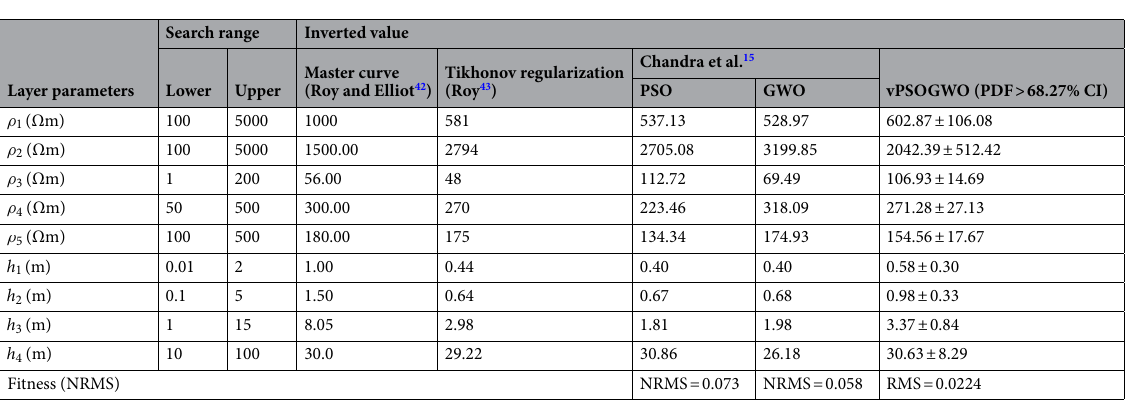
Table 8. Mean model with the level of uncertainty in the posterior utilizing individual inversion of MT data from vPSOGWO, compared with results inverted by Master curve 42 , Tikhonov regularization 42 and Chandra et al. 15 over Chatham, New Brunswick, Canada.